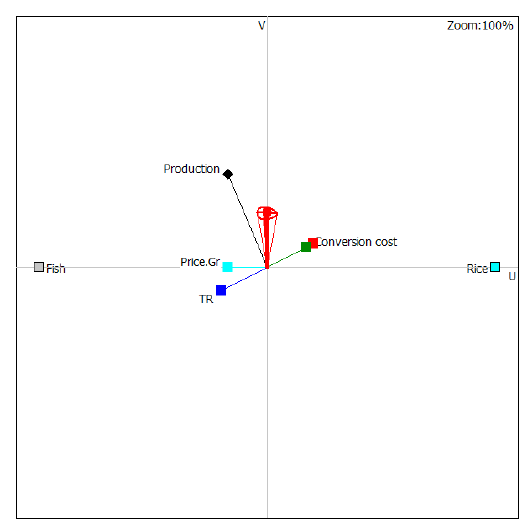
Figure 4: PROMETHEE GAIA for small-scale farmer (Source: Field survey, 2012)